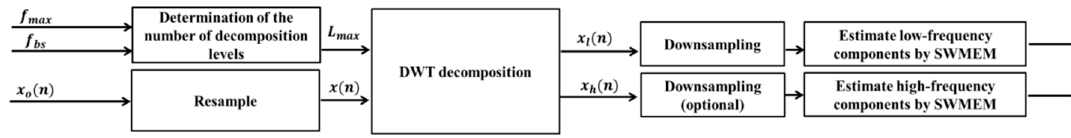
Figure 1. Scheme of the proposed method.